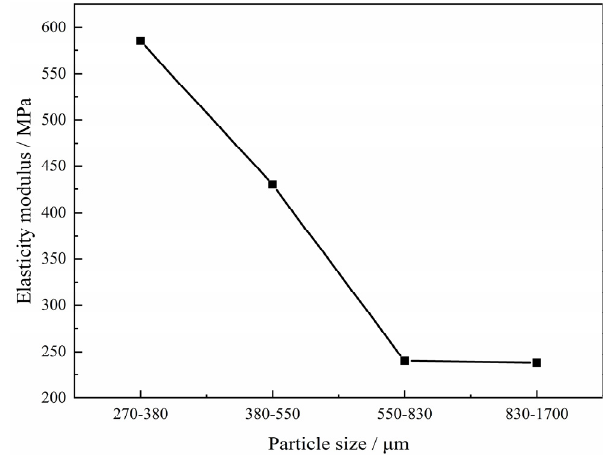
Figure 18. Effect of size of magnesium particle on elastic modulus of porous titanium.